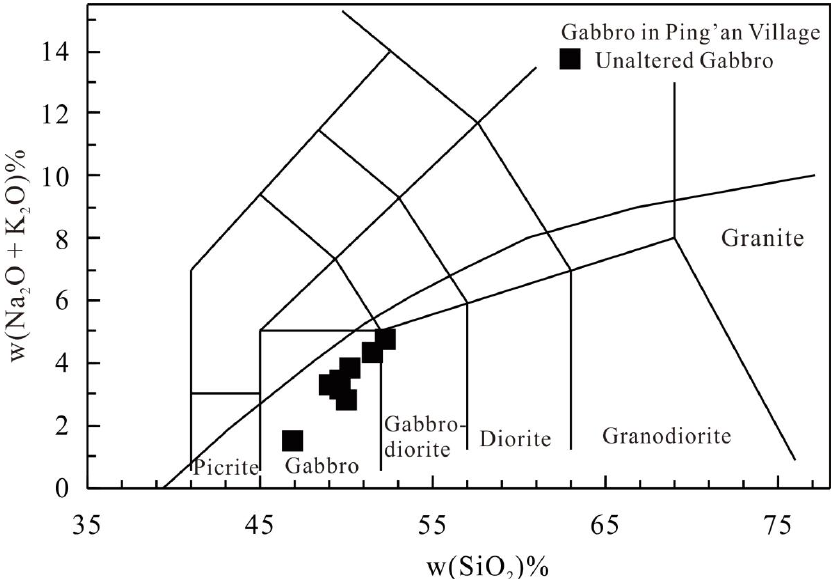
Figure 4. Total-alkalis–silica classification diagram for the fresh gabbros from the Ping’an Pb–Zn– Cu deposit.